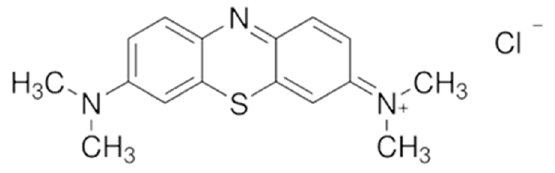
Figure 1. The chemical structure of methylene blue (MB).